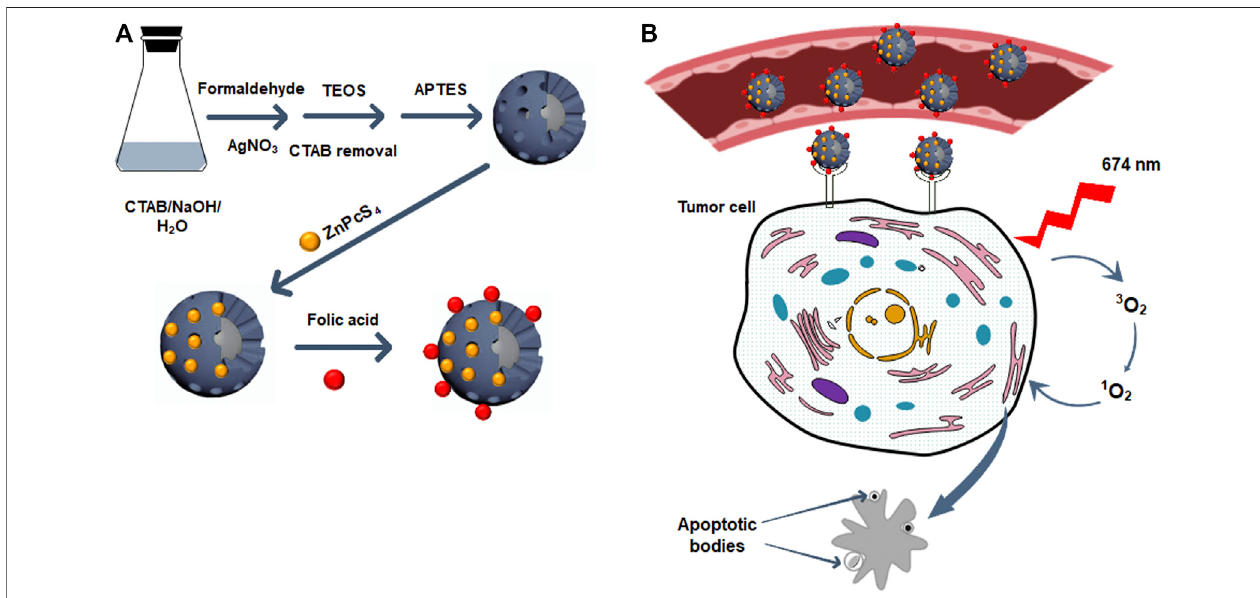
FIGURE 1 | (A) The synthetic scheme of ZnPcS 4 /Ag@mSiO 2 -FA NC. (B) The illustration of the PDT effect of ZnPcS 4 /Ag@mSiO 2 -FA NC on cancer cells: ZnPcS 4 / Ag@mSiO 2 -FA NC accumulates in tumor tissues via targeting the folate receptors on tumor cell surfaces and after irradiation at 674 nm, the PS can produce reactive oxygen species to kill cancer cells via apoptosis cell death